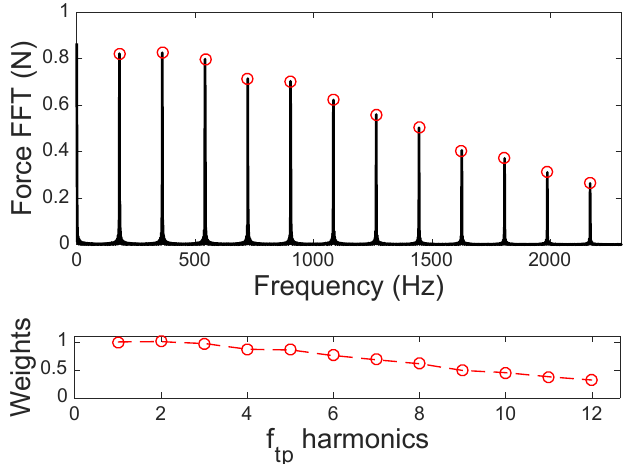
Figure 11. Harmonics weights for optimization strategy B.